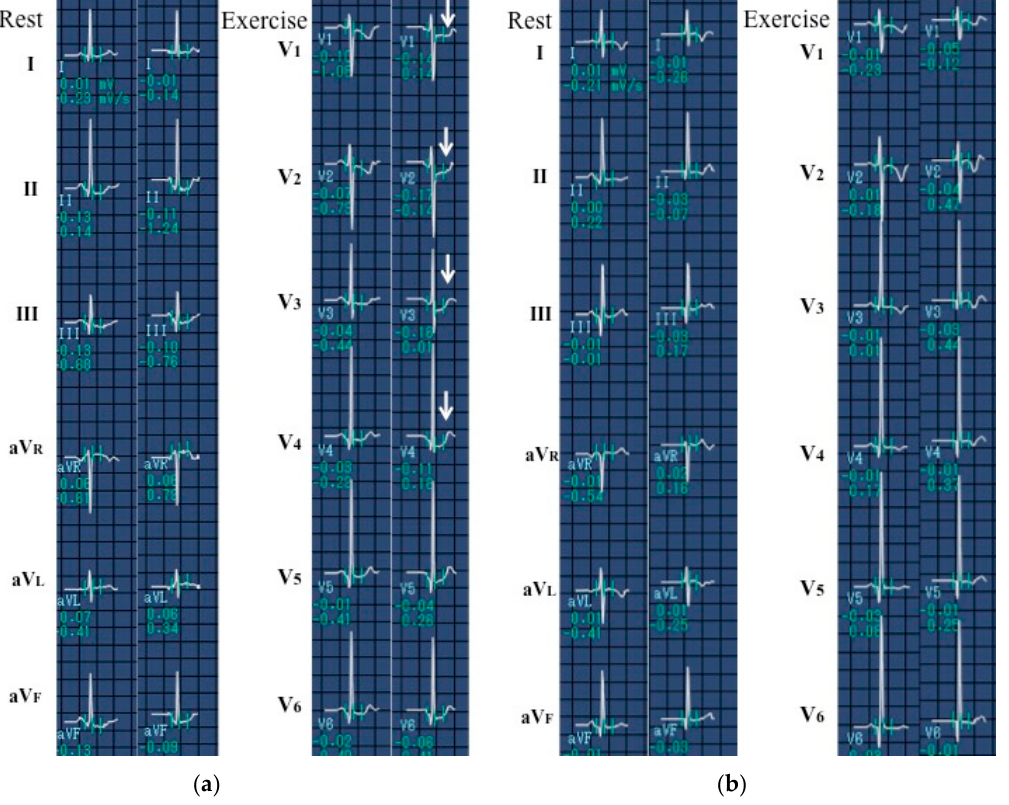
Figure 2. Findings of the treadmill testing before and after surgery. ( a ) Before surgery. During exercise, a seven-year-old Serbian girl had ST-T depression in leads V 1–4 due to severe localized stenosis of the left anterior descending artery, as shown in Figure 1. ( b ) After surgery. ST-T depression in leads V 1–4 disappeared after internal thoracic artery (ITA) grafting to the left anterior descending artery, as shown in Figure 3.